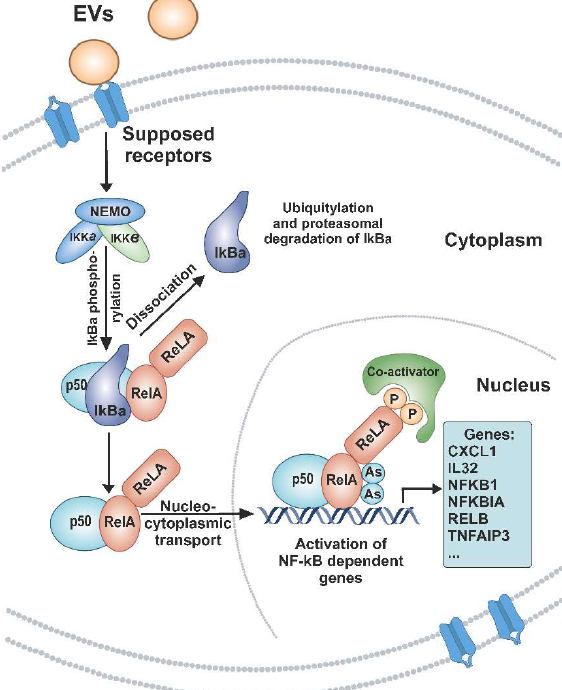
Figure 6. Hypothetical scheme summarizing the supposed processes of the NF-kB signaling pathway activation modulated by EVs and increased expression of mRNAs under the control of NF-kB. Extracellular vesicles interact with cellular receptors, which in turn, leads to a change in the activity of the kinase complex (IKK) with subsequent phosphorylation of IkBa. Phosphorylated IkBa dissociates, and undergoes ubiquitination and proteasomal degradation, which allows NF-kB dimers to move into the cell nucleus. This leads to NF-kB-dependent transcription activation.